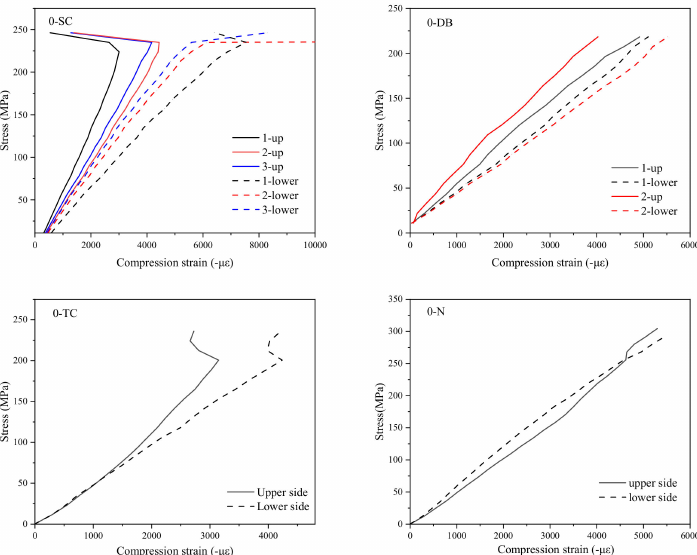
Figure 6. Stress–strain curves of specimens with particle density of 0 g/m 2 .